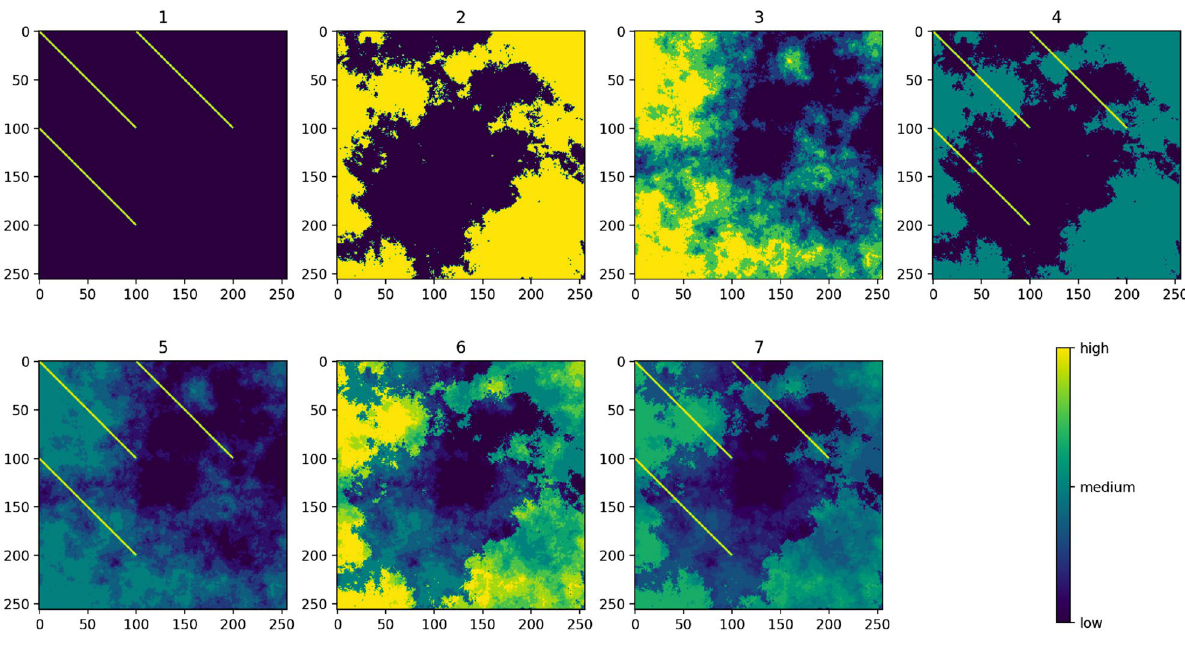
Figure 2. The seven resistance surfaces used in the